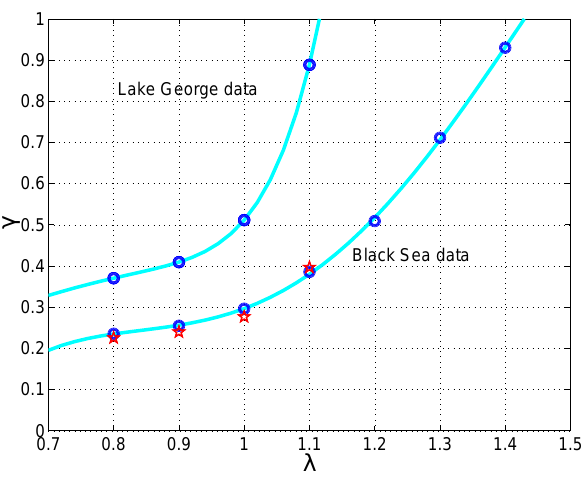
Fig. 6. The lambda-gamma graph. Circles indicate data from Ta- bles 3 and 4. Stars show conversion of finite depth values of γ according to Eqs. (9) −